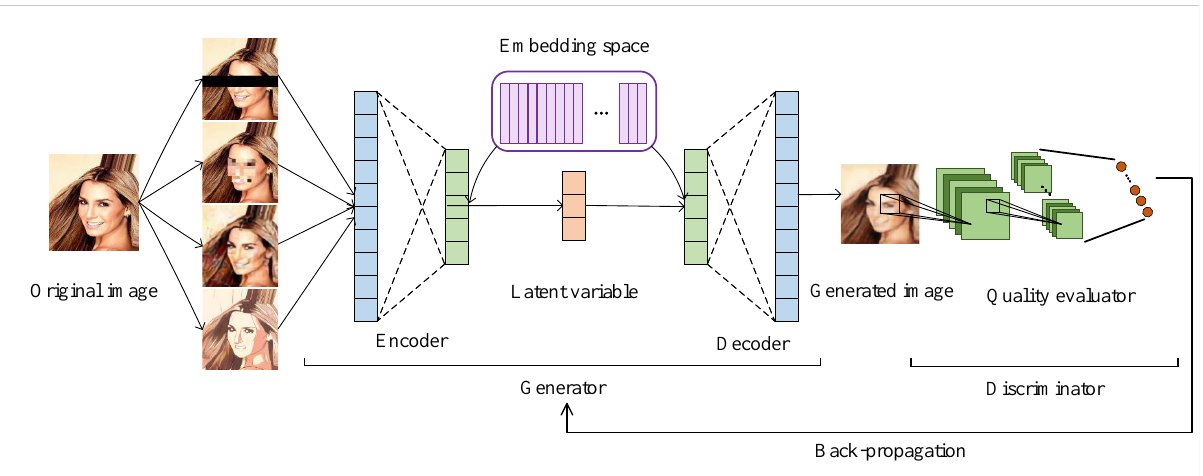
Figure 2. The overall structure of the de-identification module and